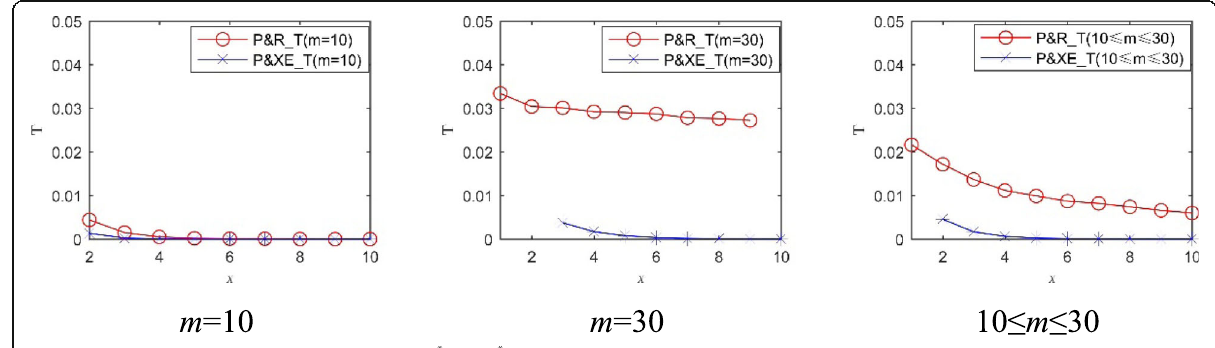
Fig. 6 Data security comparison under the same C * and O * constraints for n = 50